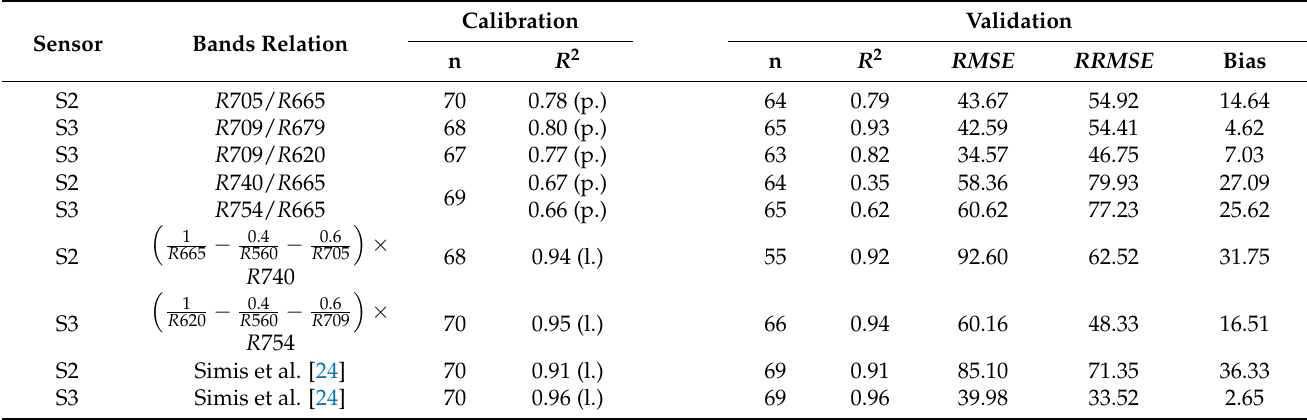
Table 9. Calibration and validation results for phycocyanin (PC). Only results with a calibration with R 2 > 0.4 are